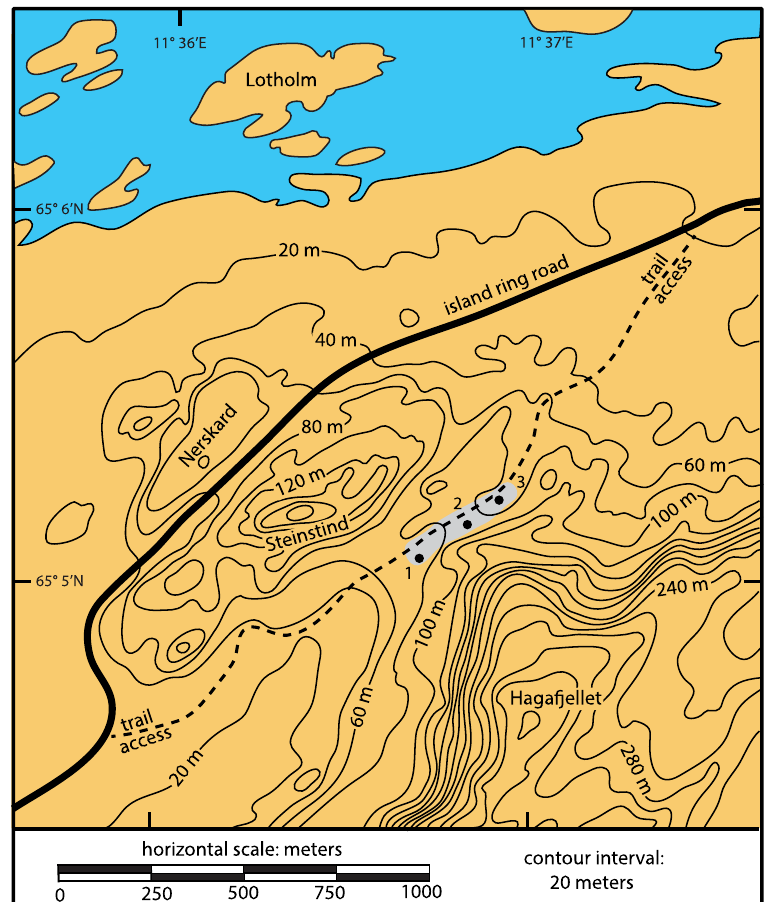
Figure 4. Topographic base map for the study area and access trail at Støypet in the National Norwegian Geological Monument on Leka Island. The shaded area near the center represents the limits of an unconsolidated cobble / boulder deposit at the pass between Steinstind and Hagafjellet. Black dots mark the location of three sample sites. See Figure 1c for orientation with respect to the rest of the island. See Figure 1c for location on Leka Island.